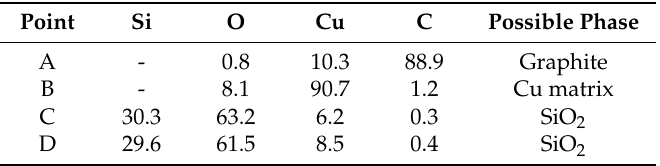
Table 4. Chemical composition (at %) of the worn surface.